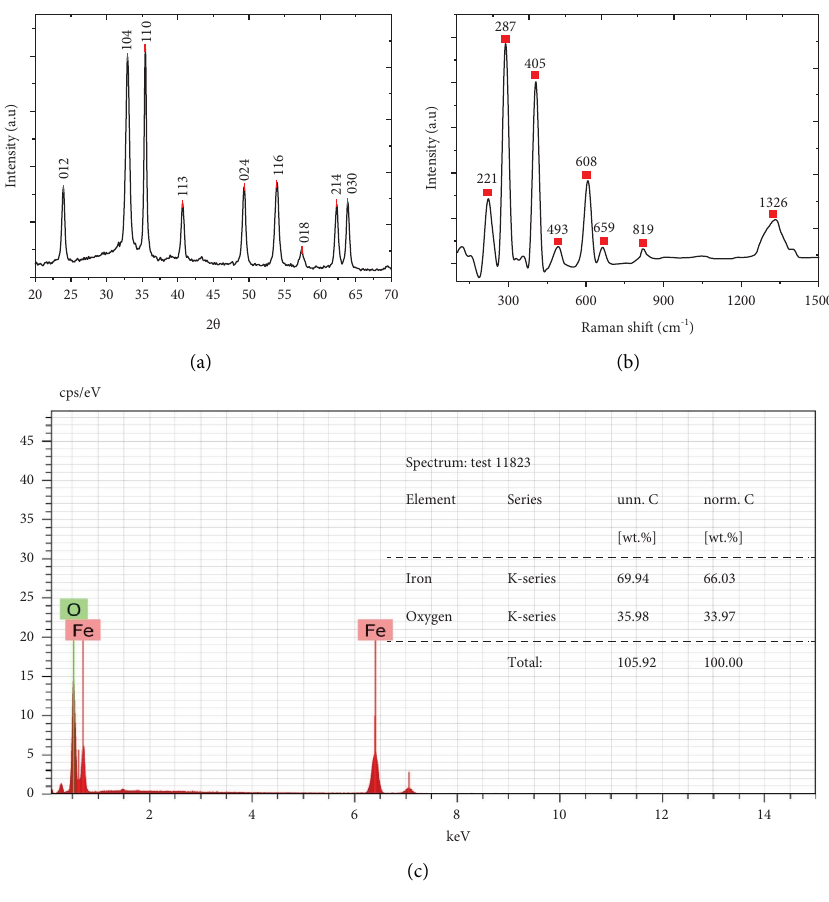
Figure 3: (a) XRD pattern, (b) Raman spectra, and (c) EDS pattern of synthesized α -Fe